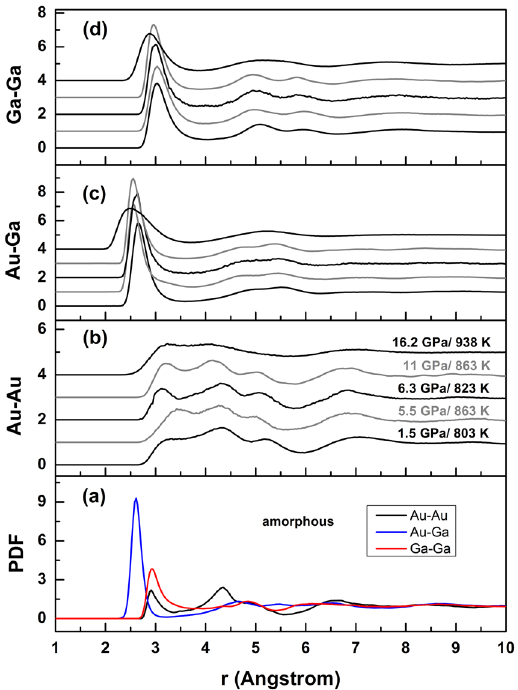
Figure 5. Au-Au, Au-Ga, and Ga-Ga partial pair distribution functions calculated from the EPSR simulations for ( a ) amorphous AuGa 2 at P = 0 and T = 300 K, and ( b , c , d ) liquid AuGa 2 under